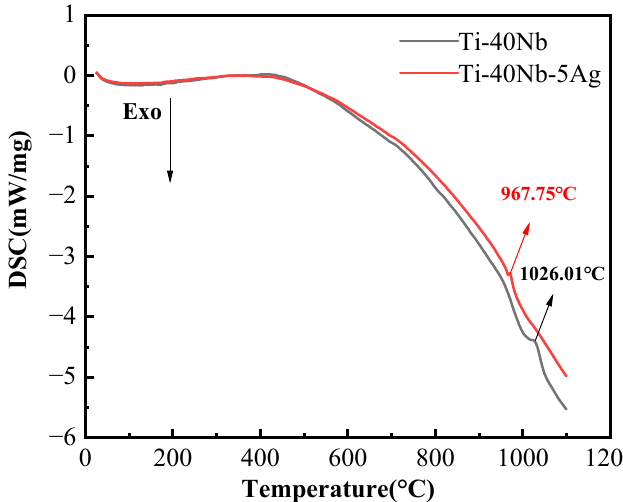
Figure 2. DSC curve of Ti-40Nb-10Ag and Ti-40Nb ball-milled alloy powders. Table 1. The processing parameters of experimental samples.